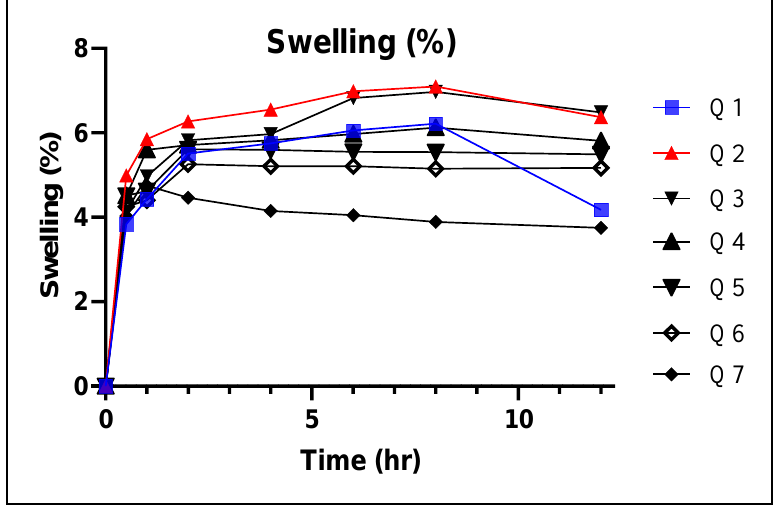
Figure 4. Swelling index of compressed tablet composites.